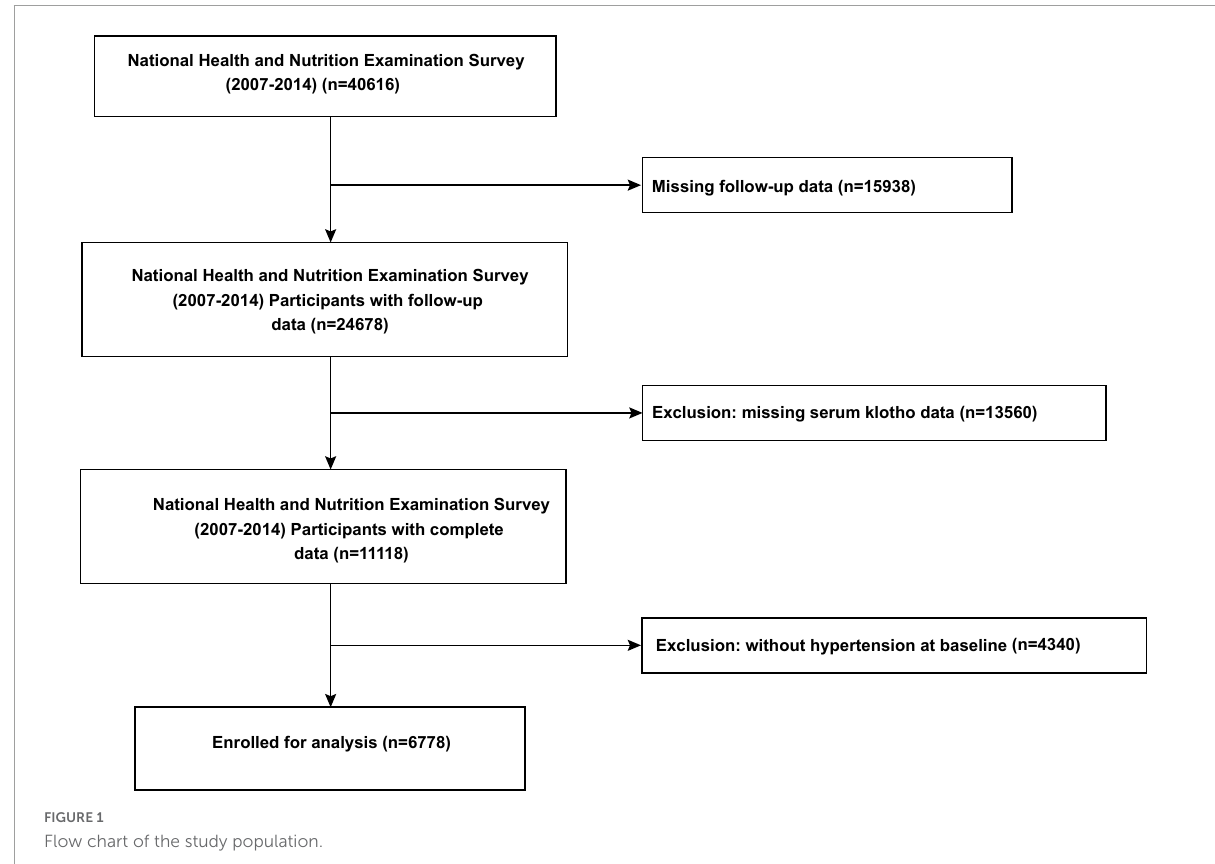
FIGURE1 Flow chart of the study